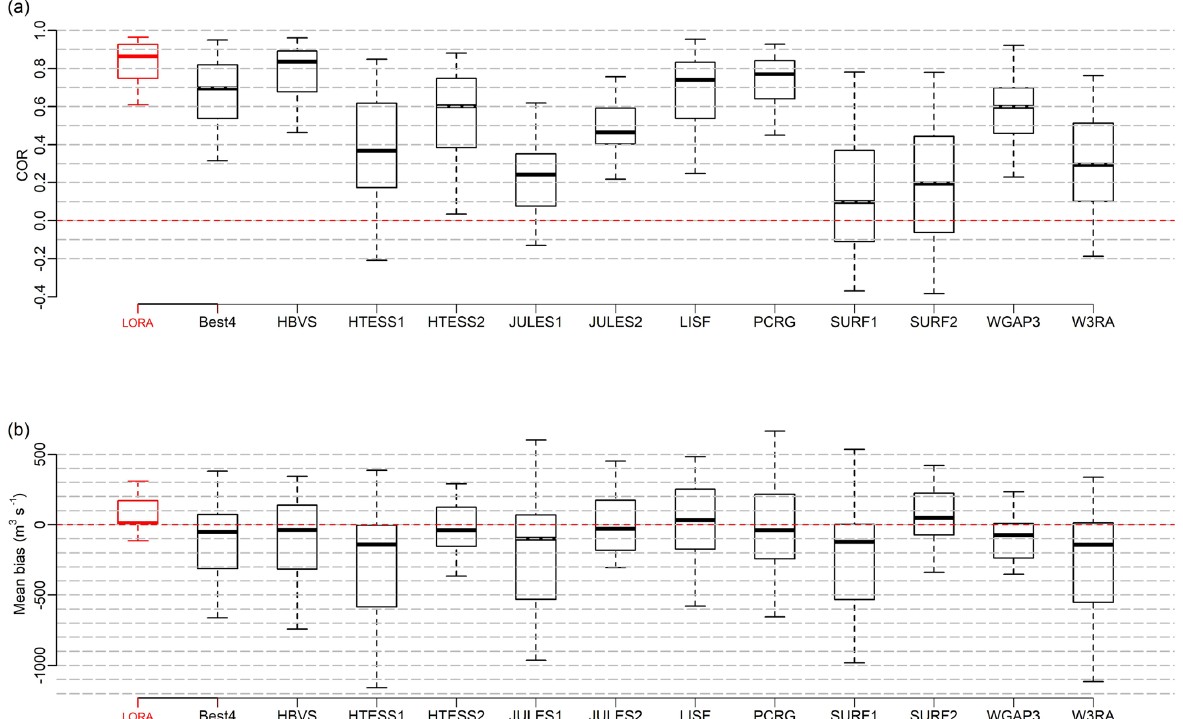
Figure 7. Two statistics, (a) COR and (b) mean bias, calculated for LORA, Best4 (i.e. the simple average of runoff estimates from LIS- FLOOD, WaterGAP3, W3RA and HBV-SIMREG) and each runoff product involved in this study at the gauged basins located at the high latitudes ( > 60 ◦ ). See Table 1 for dataset abbreviations.